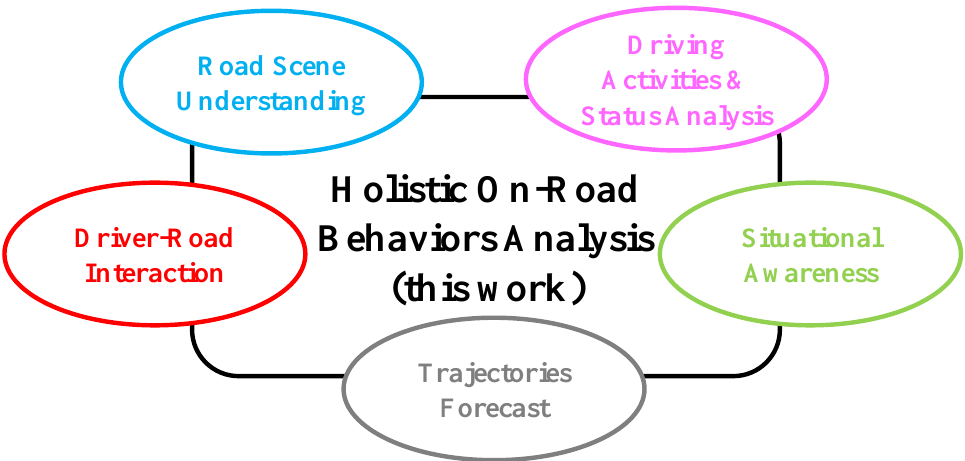
Figure 2. A pictorial description of the contents of this work, i.e., on-road behavior analysis compo- nents: situational awareness, driver-road interaction, driving activities and status analysis, trajectories forecast, and road scene understanding along with holistic endeavors that provide a broad under- standing of road